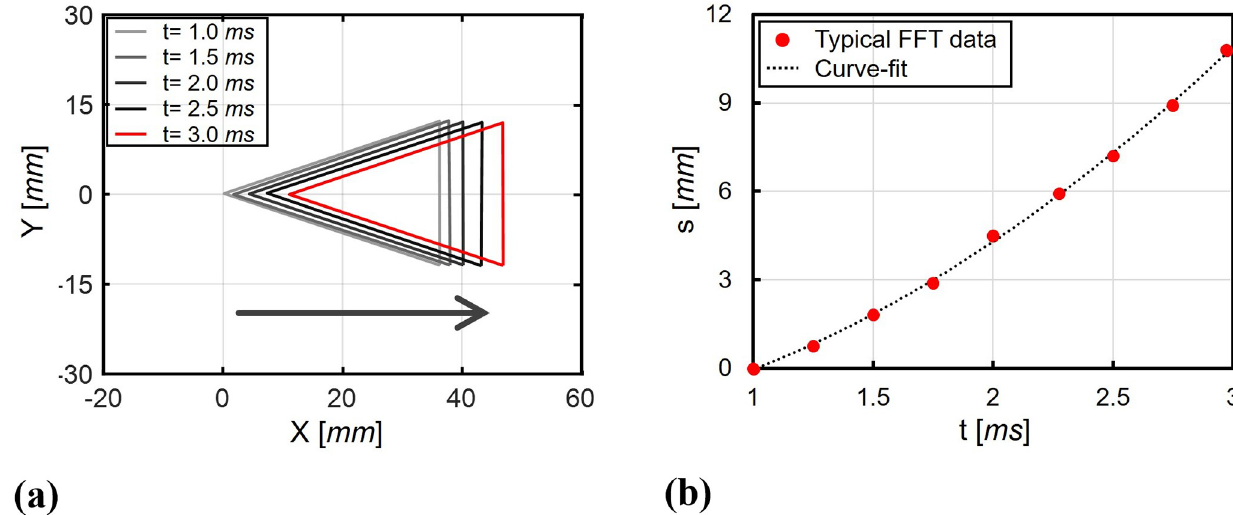
Fig 11. Corner detection results of the free-flying model in the FFT. (a) Typical detected corners, (b) Cumulative displacements.